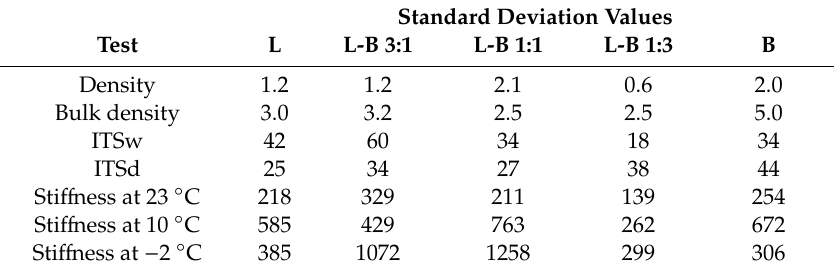
Table 6. Standard deviation values for particular groups of